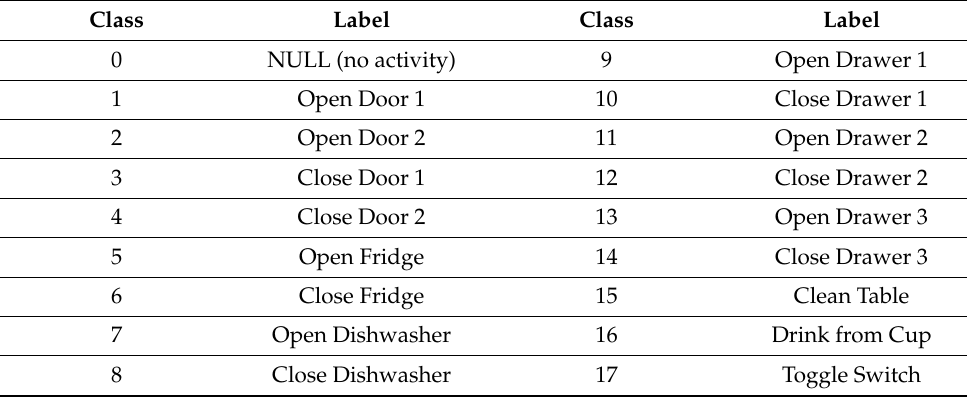
Table 2. Activity classes of the OPPORTUNITY dataset.